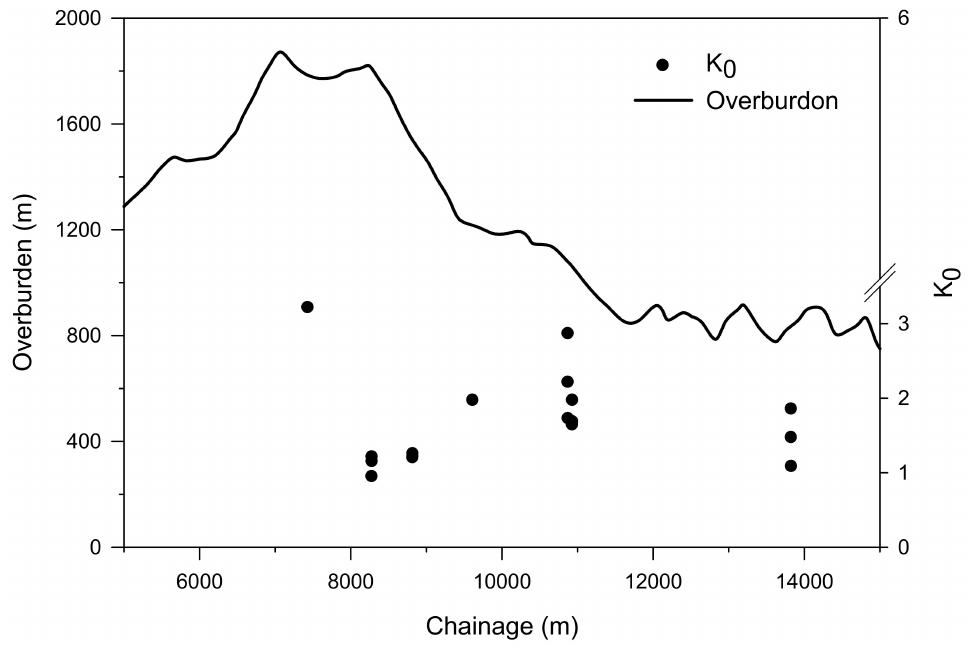
Figure 5. In situ stress state along headrace tunnels in sever rock burst